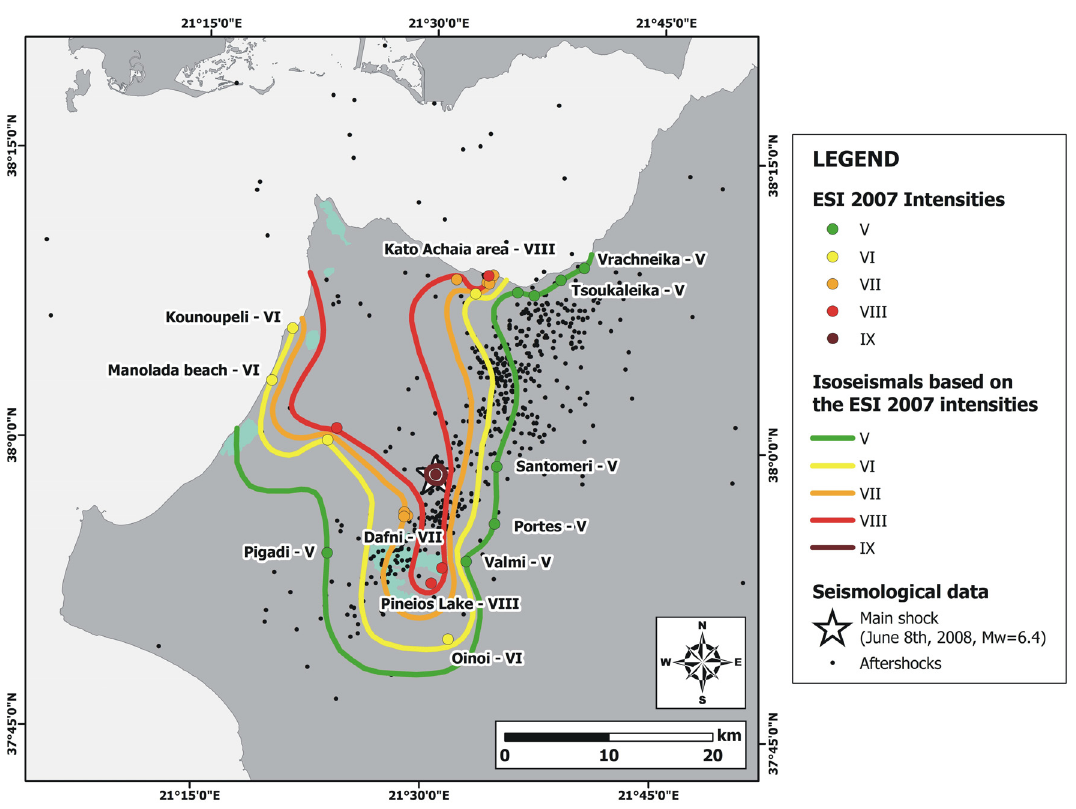
Figure 4. The 2008 Andravida earthquake isoseismal map based on the ESI 2007